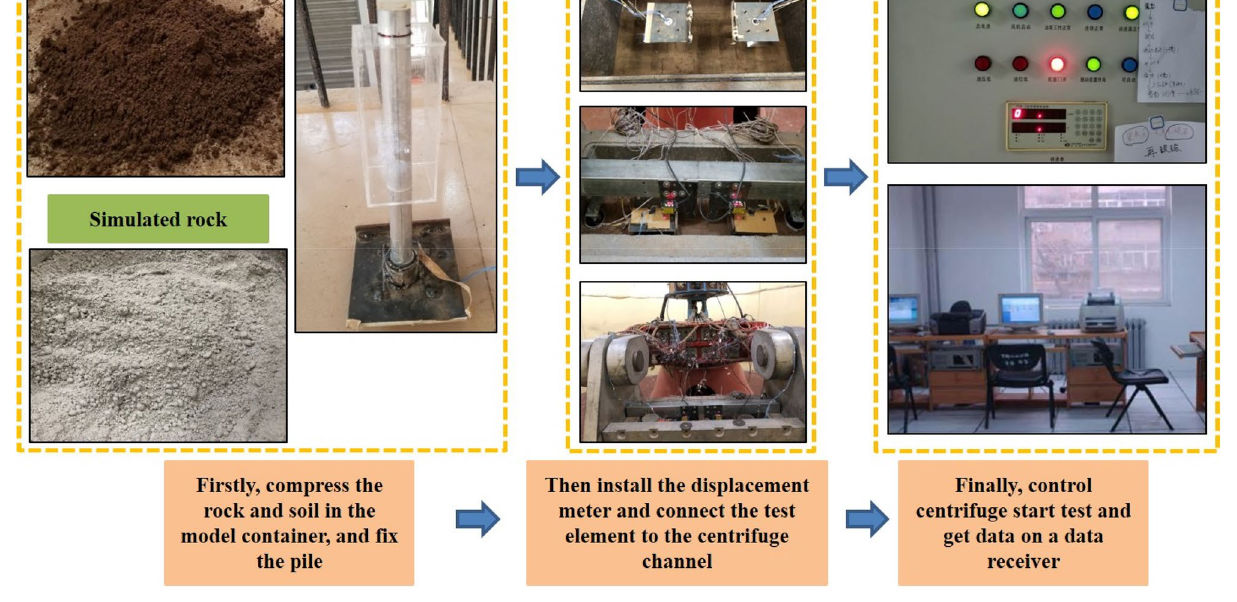
Figure 15. Test process.